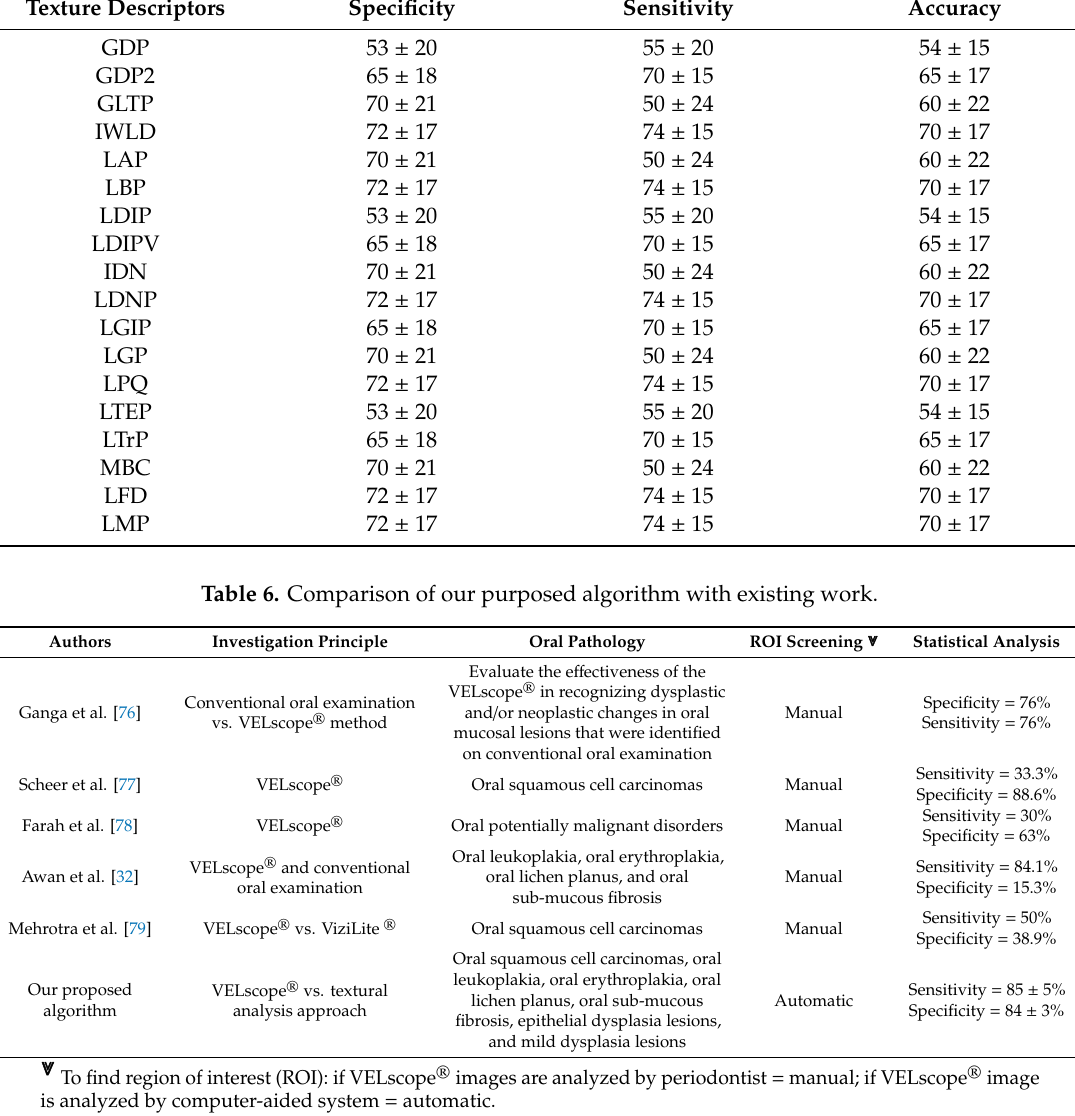
Table 5. Analysis of OPMD vs. typical oral cavity region using multiple textural descriptors.